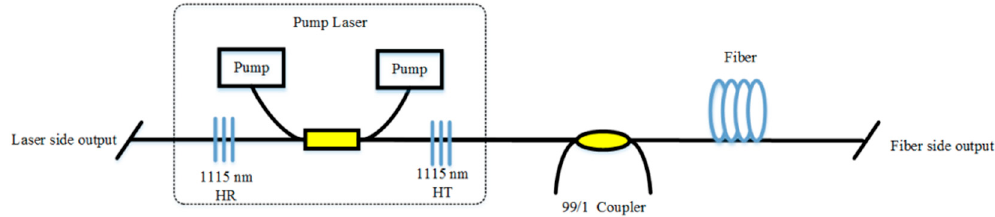
Figure 9. The scheme of RFL pumped by ytterbium-doped fiber laser (YDFL). HR, high reflection; HT, high transmission.